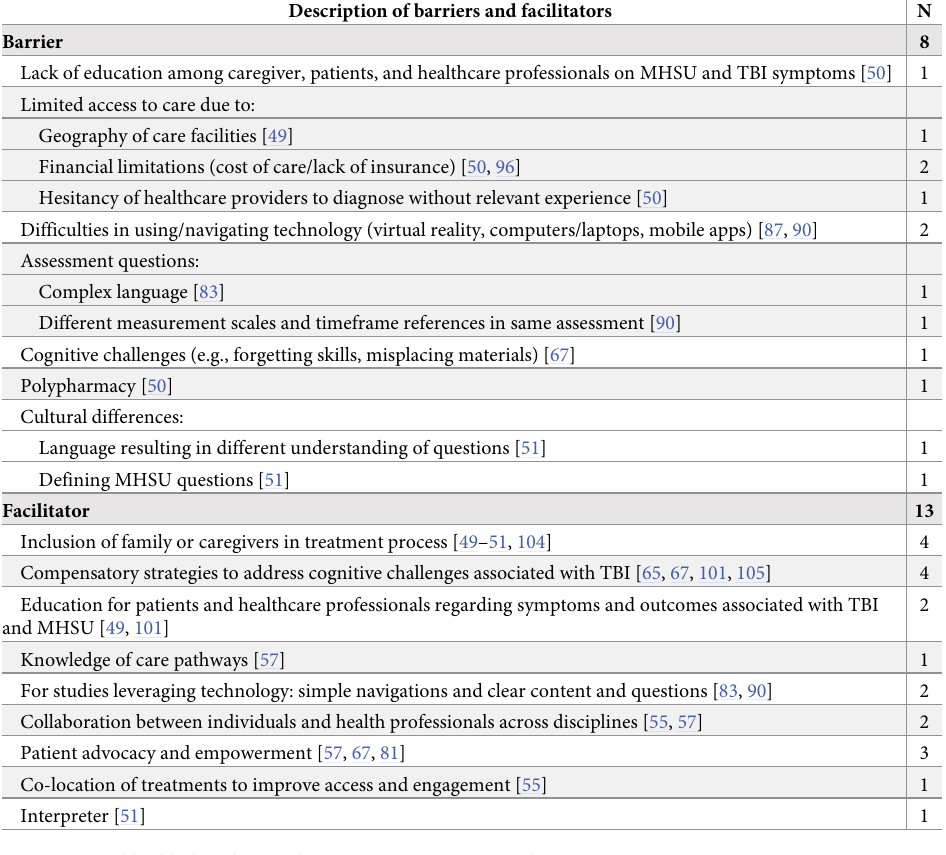
Table 5. Summary of barriers and facilitators. Description of barriers and